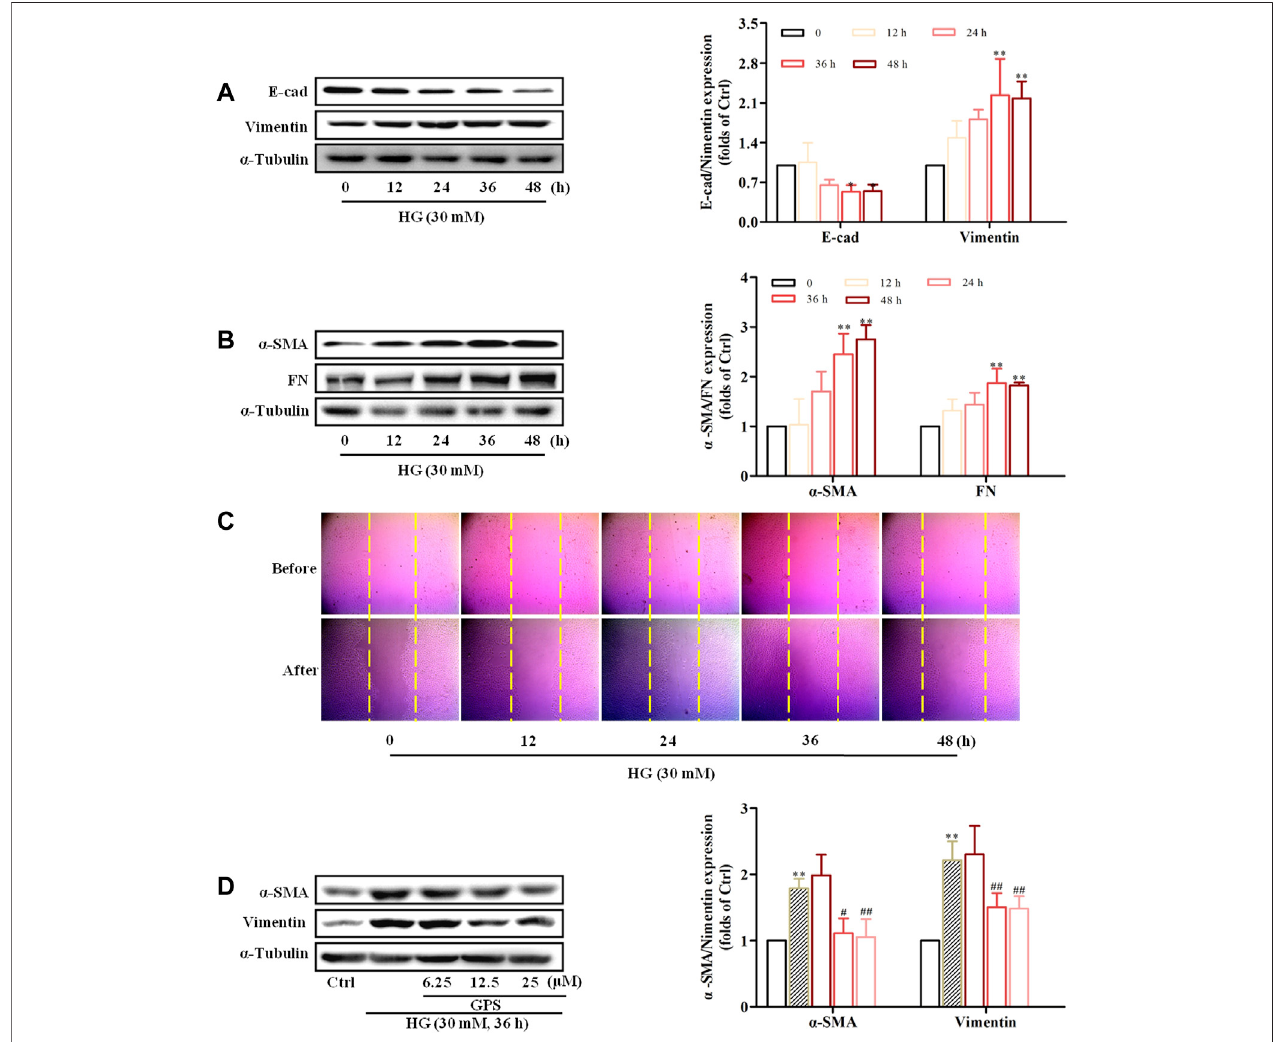
FIGURE4| HG-inducedEMTinNRK-52EcellsandGPSinhibitedHG-inducedEMTinNRK-52Ecellsstartingat12.5 μ M.( A,B )ProteinlevelsofE-cad,vimentin, α - SMA, and FN under the HG conditions at various times were detected by Western blot. ** p < 0.01 and * p < 0.05 vs . 0 h. (C) Migration ability ofNRK-52Ecells under the HGconditionsatvarious timeswasdetectedbyacellscratchtest. ** p < 0.01and * p < 0.05 vs .0 h. (D) Proteinlevelsof α -SMAand vimentinafter GPSintervention were detected by Western blot. ** p < 0.01 vs . Ctrl, ## p < 0.01 vs . HG. Data were expressed as mean ± SD.